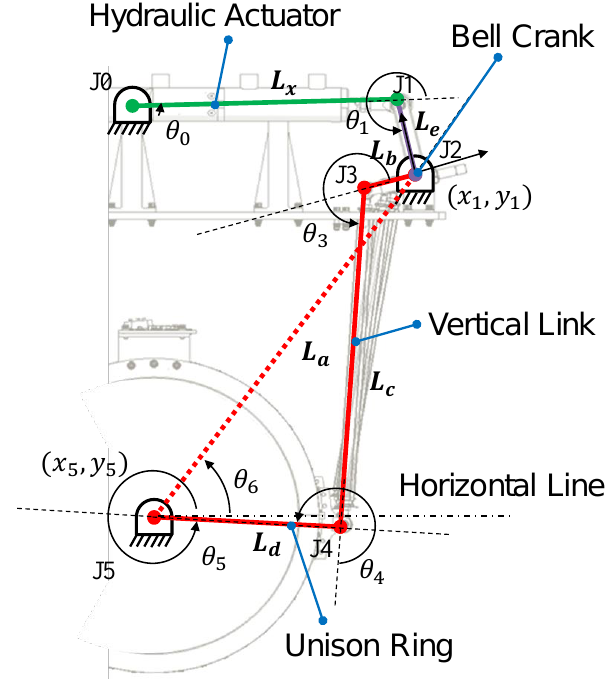
Figure 2. Simplified diagram of VGV links and joints